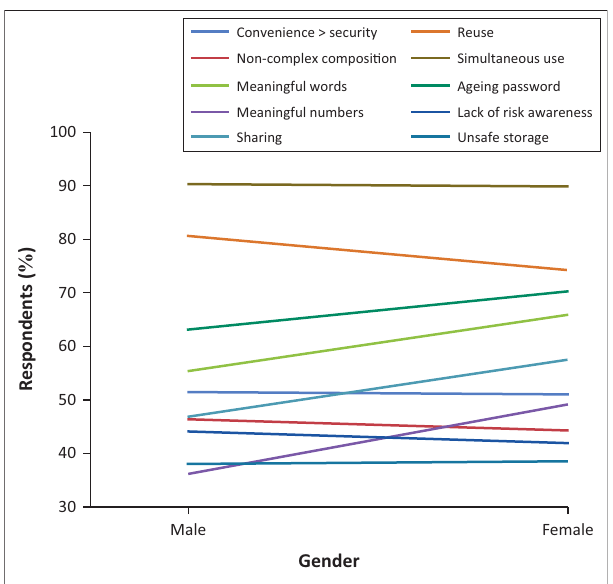
FIGURE 4: Weak password practices per gender.